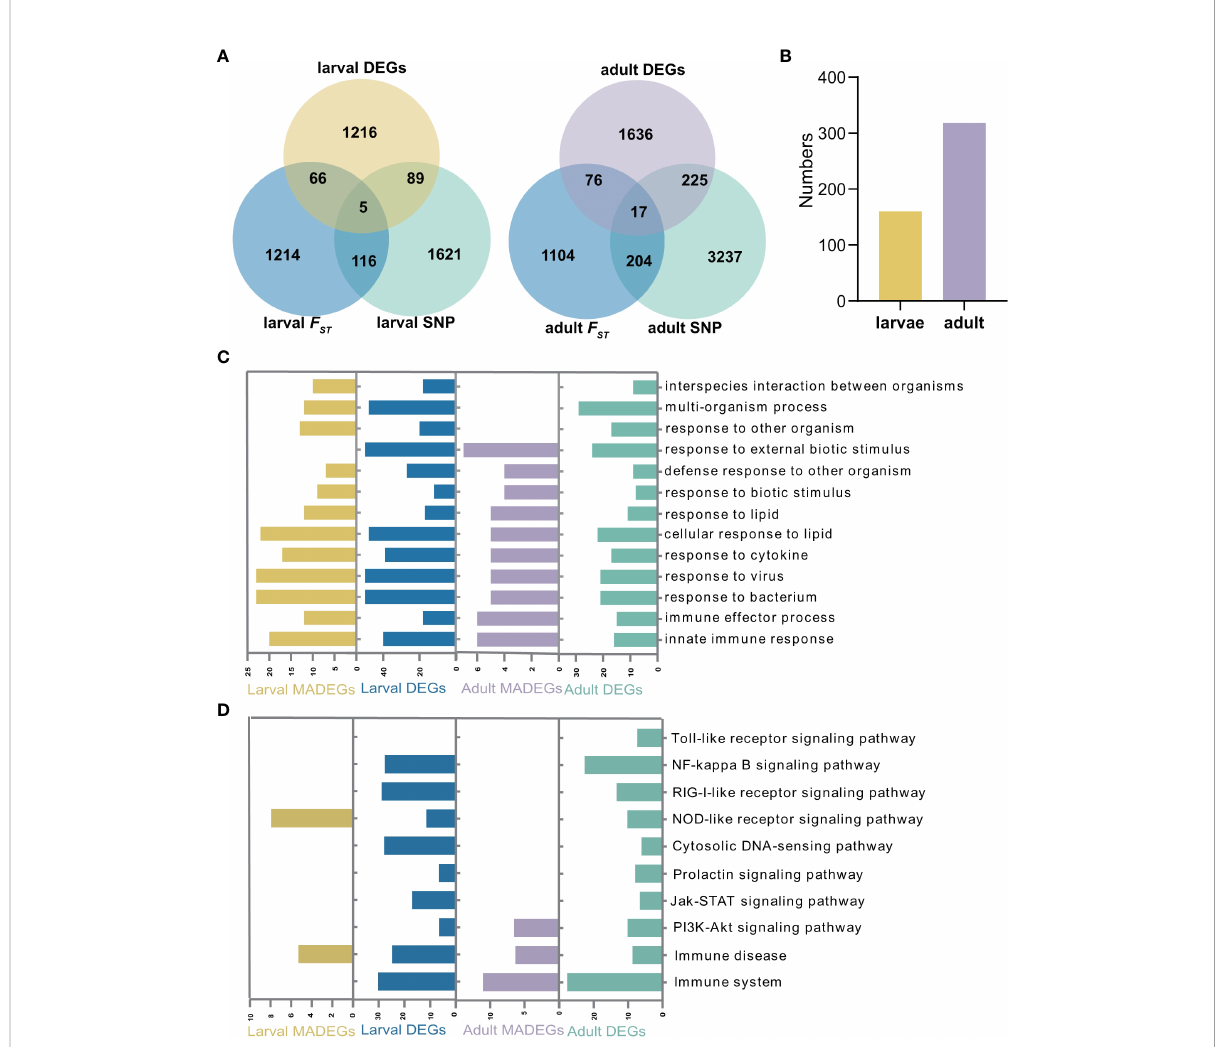
FIGURE 4 Analysis of differentially expressed and mortality-associated genes. (A) Venn diagrams of differentially expressed and mortality associated genes in larval and adult populations, respectively. DEG: differential expressed genes under virus infection. (B) The number of mortality-associated DEGs (MADEG) in larvae and adult populations, respectively. (C) The Gene Ontology (GO) and (D) Kyoto Encyclopaedia of Genes and Genomes (KEGG) enrichment analyses of the MADEGs in larvae and adult populations, and their comparisons with all